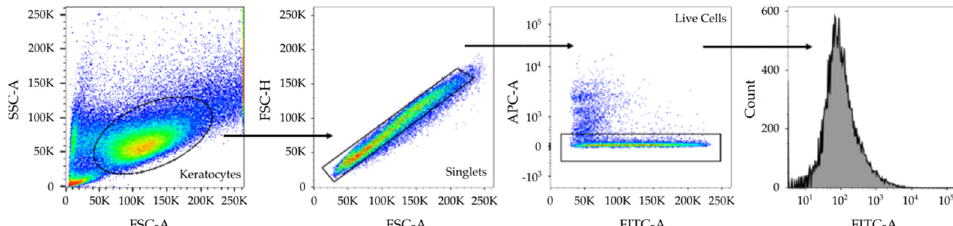
Figure 4. Schematic of sample plots demonstrating the gating strategy employed on raw data in FlowJo to generate graphs. Forward vs. side scatter area (FSC-A vs. SSC-A) gating was applied to identify cells of interest based on size and complexity (granularity) , whereas FSC-A vs. forward scatter height (FSC-H) gating strategy was applied for the purposes of doublet exclusion. To distinguish between live and dead cells, FSC-A was gated against allophycocyanin area (APC-A) to detect fluorescence emitted by the Live/Dead TM Fixable Far Red Dead Cell stain. Finally, a fluorescein isothiocyanate area (FITC-A) vs. histogram parameter change was applied to generate a log-distribution of gated events. Pseudocoloured density plots depict the distribution of cells within a population. Blue and green correspond to areas of lower cell density, yellow corresponds to areas of mid-range cell density, and red correspond to areas of high cell density.